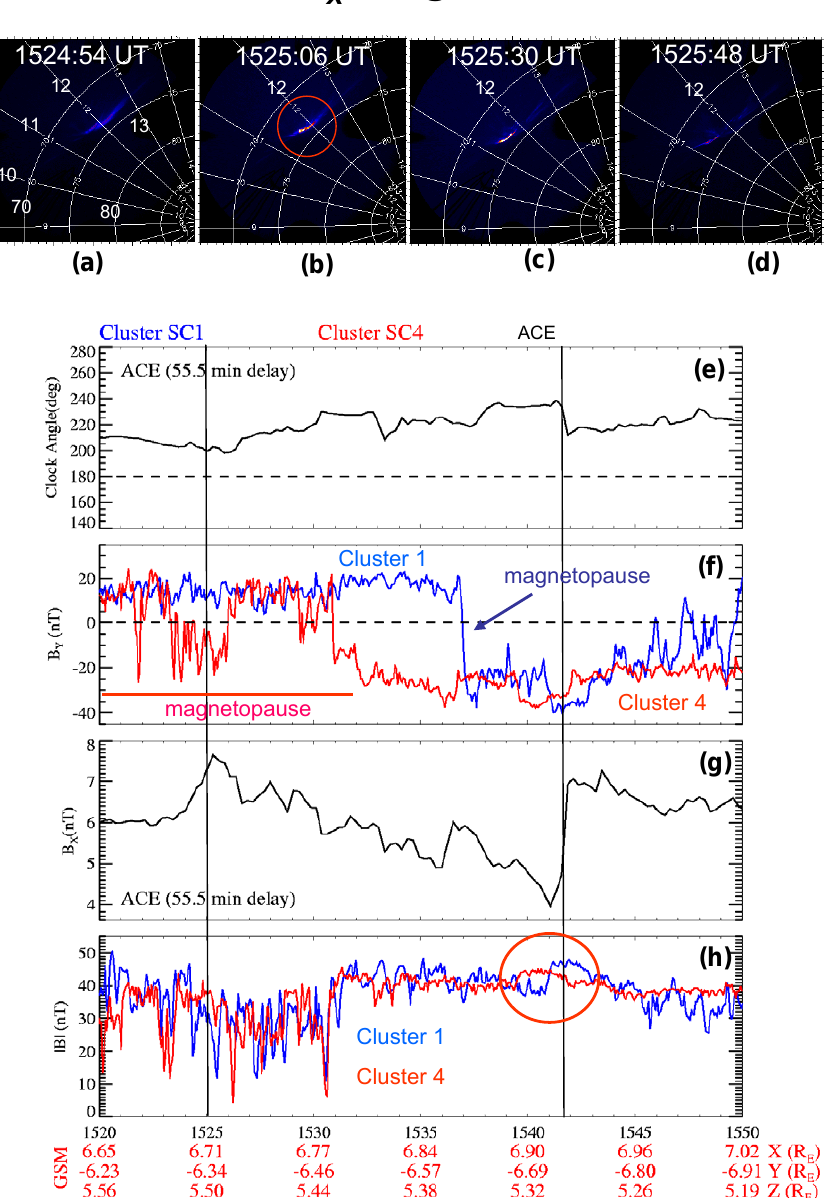
Fig. 9. Responses to increases in B X . (a–d) 557.7nm all-sky images near the period the increase in emissions at 15:25 UT. In data traces (e–h) the colors black, blue and red denote data source as ACE, Cluster 1 and Cluster 4, respectively. The four line trace panels show the clock angle, B Y , B X , and the magnitude of B . The left vertical line notes the increase in B X at the same time as the emission increase in panel (b). The right vertical line highlights the large increase in IMF B X . At this time (panel h) an increase in B is seen first by Cluster 4 and then by Cluster 1, which is closer to the